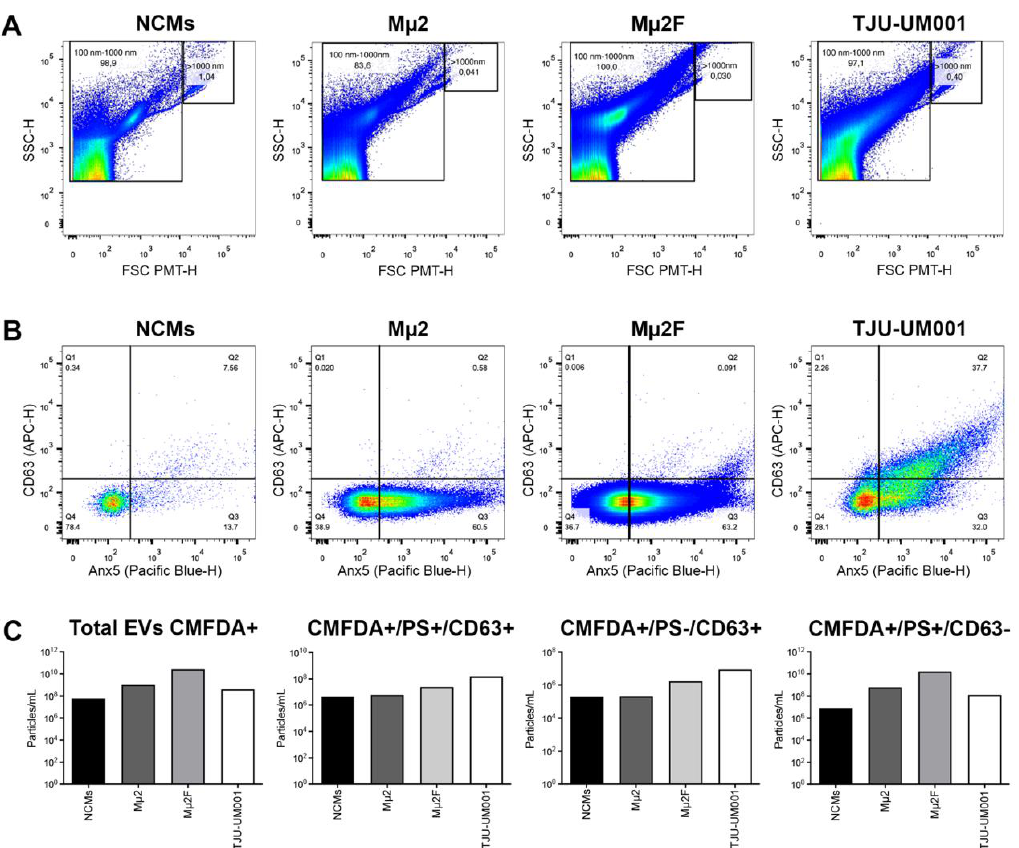
Figure 1. UM cells release more EVs than melanocytes. The size distribution of EVs derived from NCMs, non-metastatic UM cell line M µ 2, and metastatic cell lines M µ 2F and TJU-UM001 was determined by HR-FC. ( A ) EV size was determined with forward and side scatter, and EVs between 100 – 1000 nm were included in the analysis. ( B ) The NCM- and UM-derived EVs were stained with CMFDA to identify intact EVs and exclude debris. CMFDA-positive events were analyzed for Anx5 (PS)/CD63 expression. ( C ) The concentration of EVs (particles/mL) for the various CMFDA+/PS/CD63 subpopulations was determined by normalizing the number of particles to the total volume acquired for each sample.